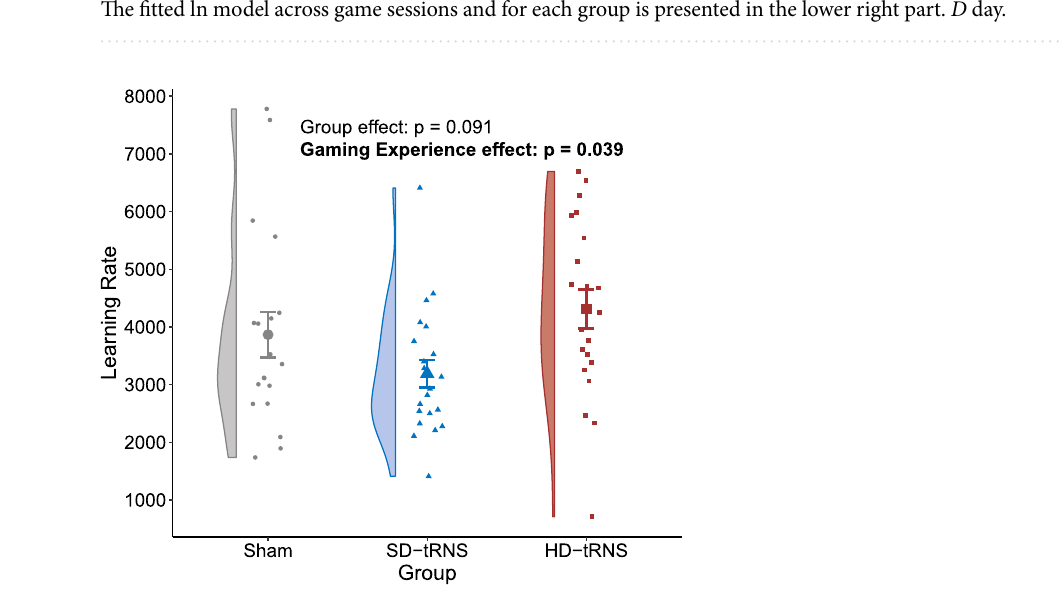
Figure 3. Learning rate by stimulation group (Hypothesis 1). Bold: p < 0.05